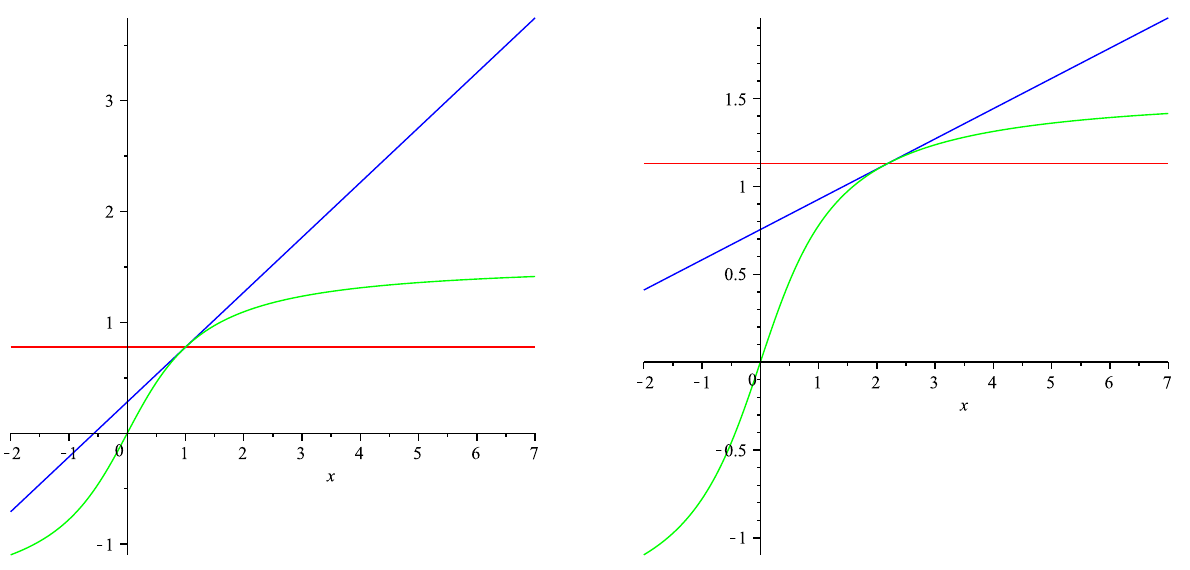
Figure 1. (cid:27) ( t; x ) in green, (cid:27) ( t; E [ X ( t )]) in red and (cid:27) lin ( t; x ) in blue for t = 0 ( left ) and t = 10 ( right